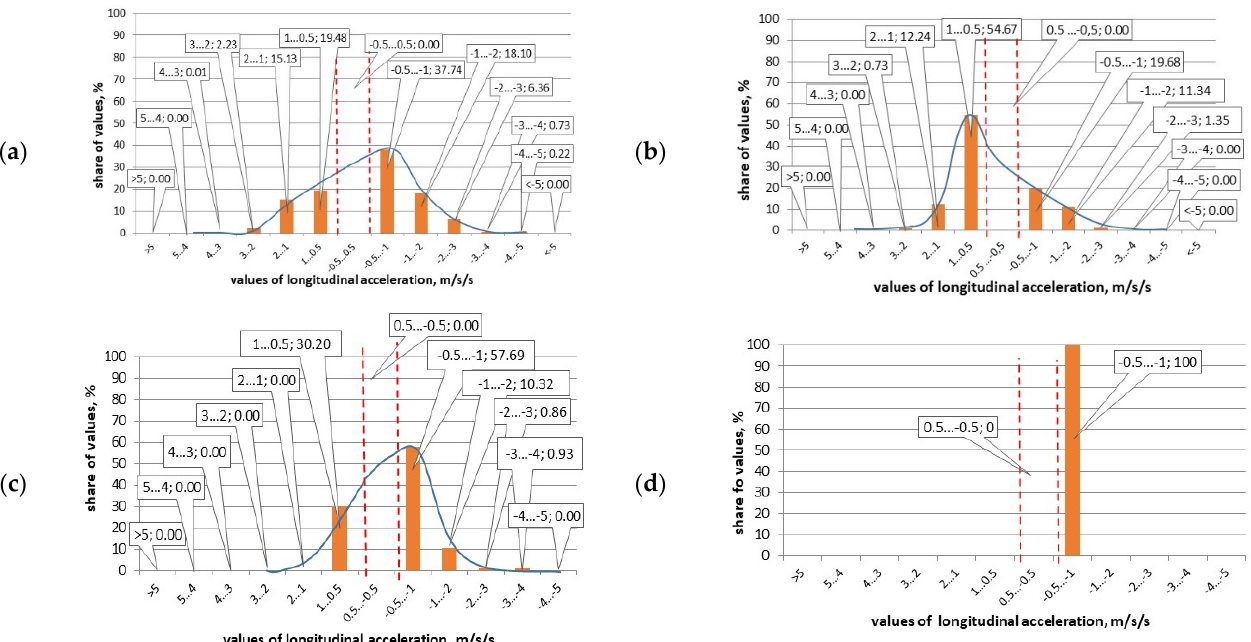
Figure 10. Longitudinal acceleration values excluding the ‘constant speed’ driving range on various road types: ( a ) urban area (city); ( b ) non-urban area (single roadway with two traffic lanes); ( c ) two-roadway expressway; ( d ) motorway.